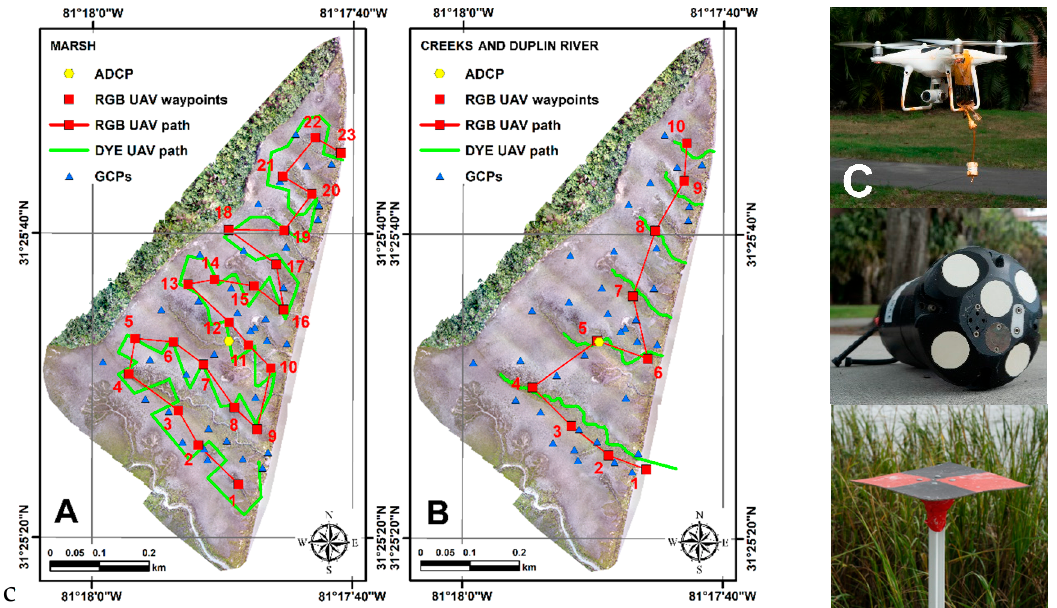
Figure 4. Spatial distribution of the flight path for the two UAVs over ( A ) the salt marsh and ( B ) the tidal channels. The positions of the ground control points (GCPs) and the ADCP are also shown. ( C ) Pictures of the DJI Phantom 4 Pro UAV with the dye-filled IV-bag (top), the ADCP sensor used to measure the velocity (middle), and an elevated GCPs (bottom).